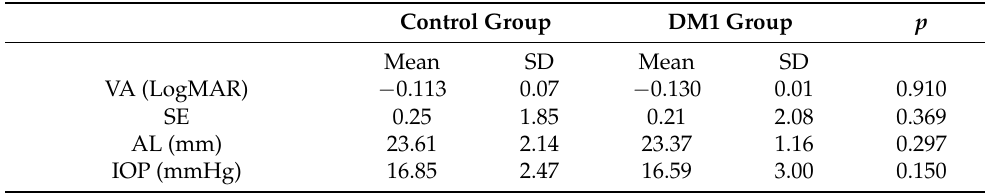
Table 1. Mean, standard deviation (SD) and statistical significance ( p -value) of visual acuity (VA) in the LogMAR scale, spherical equivalent (SE) in diopters (D), axial length (AL) in mm and intraocular pressure (IOP) in mmHg between the control and type 1 diabetes mellitus (DM1) group. No statistical differences were found between groups ( p > 0.05). Control Group DM1 Group p Mean SD Mean VA